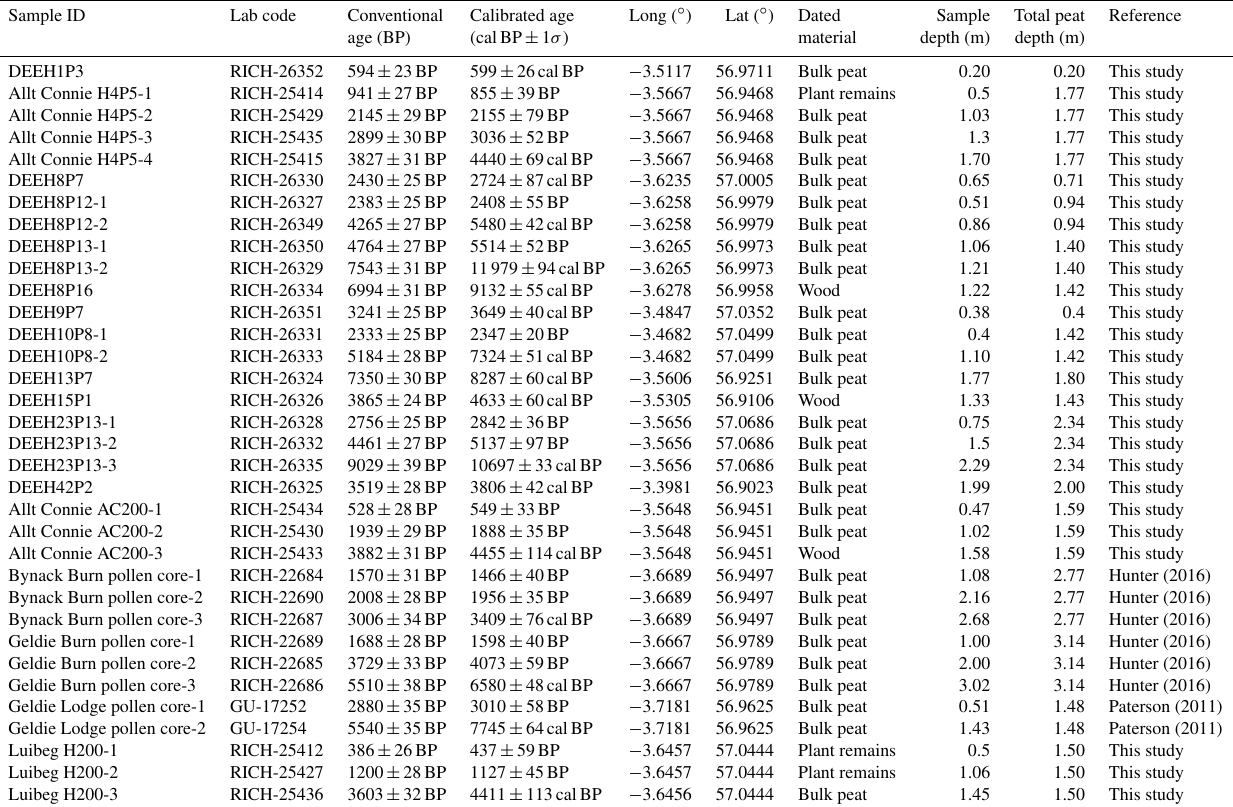
Table A2. Radiocarbon dating results. Calibrated ages were cal- culated using the software OxCal 4.3 and the IntCal13 calibration curve (Bronk Ramsey, 2009; Reimer et al.,